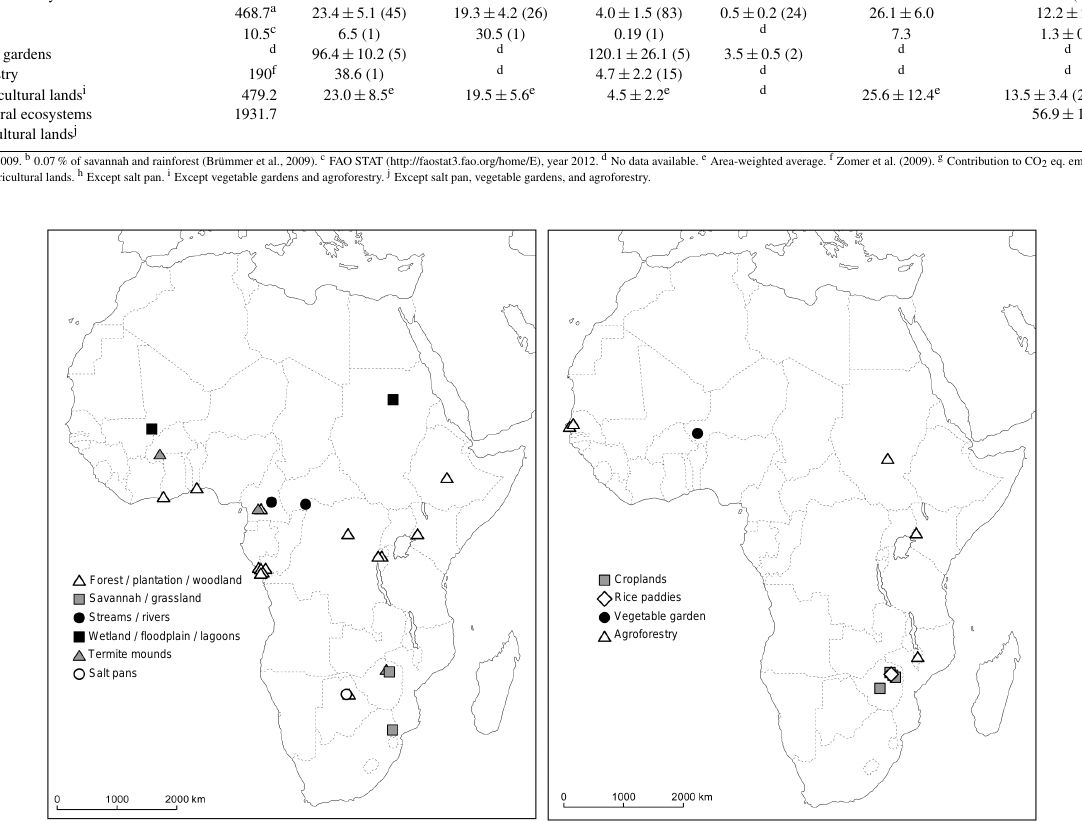
Figure 2. Maps showing study sites of CO 2 , CH 4 , and N 2 O fluxes in natural ecosystems (left) and agricultural lands (right) in sub-Saharan